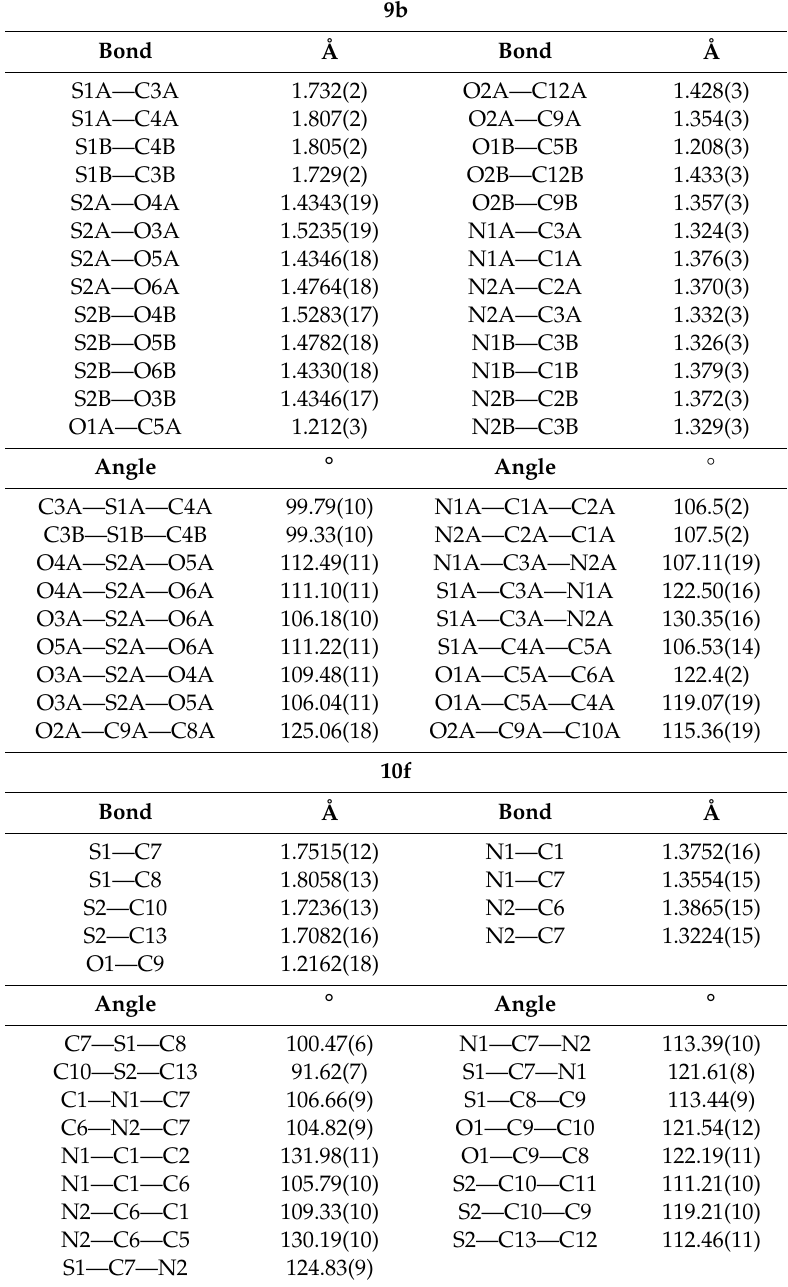
Table 1. Selected geometric parameters (Å, ◦ ) of imidazole sulfate-salt 9b and benzimidazole derivative 10f